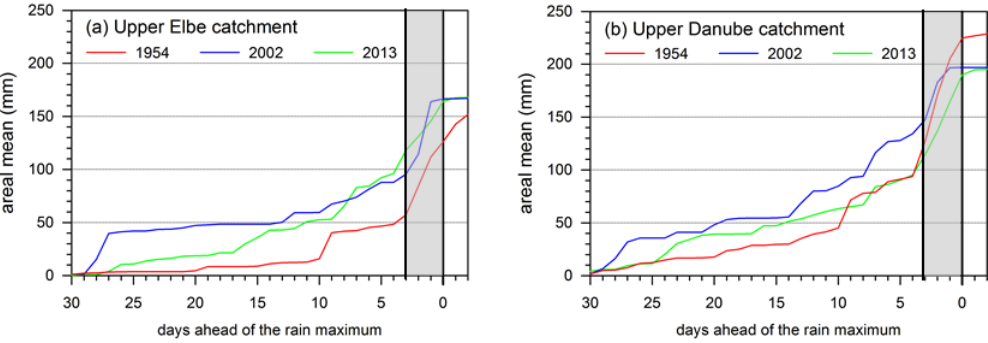
Figure 3. Time series of cumulated areal mean precipitation for the upper Elbe catchment in Germany up to the inflow of the Saale River ( a ; area: 63171km 2 ) and for the upper Danube catchment in Germany ( b ; area: 51379km 2 ). The x -axis marks the days prior to the 3-day maximum precipitation totals. Event precipitation is highlighted in